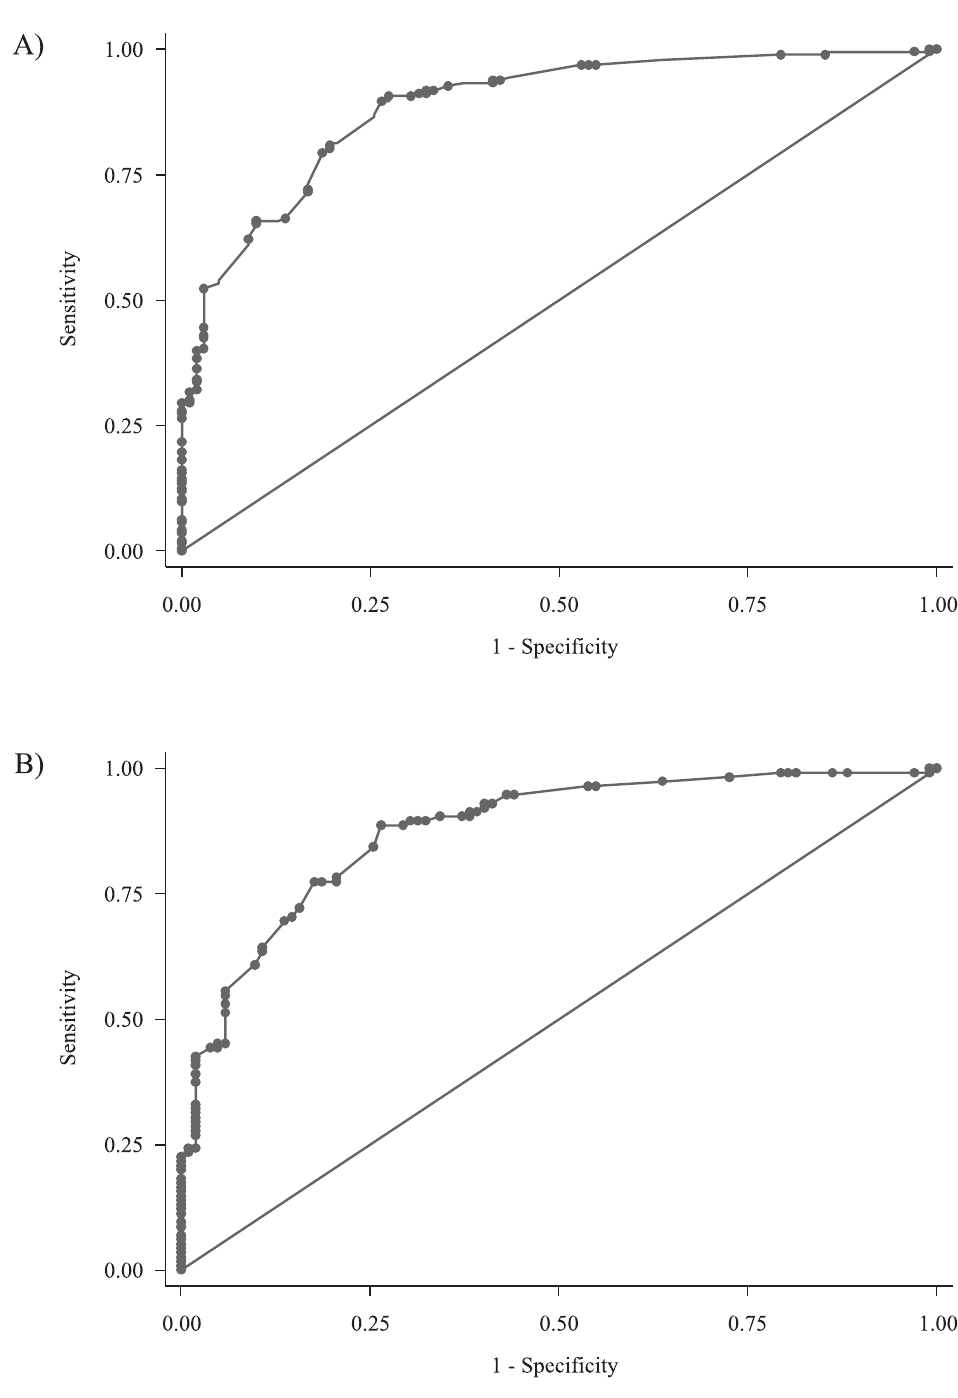
Fig 3. Receiveroperating characteristics curves for colorectal cancer. Note. A) ROC curve for all stage CRC with a non-optimism corrected AUC of 0.8870. B) ROC curve for stage I and II CRC with a non-optimism corrected AUC of 0.8775. Receiveroperatingcharacteristics (ROC). Colorectalcancer (CRC). Area under the receiveroperatingcharacteristics curve (AUC).